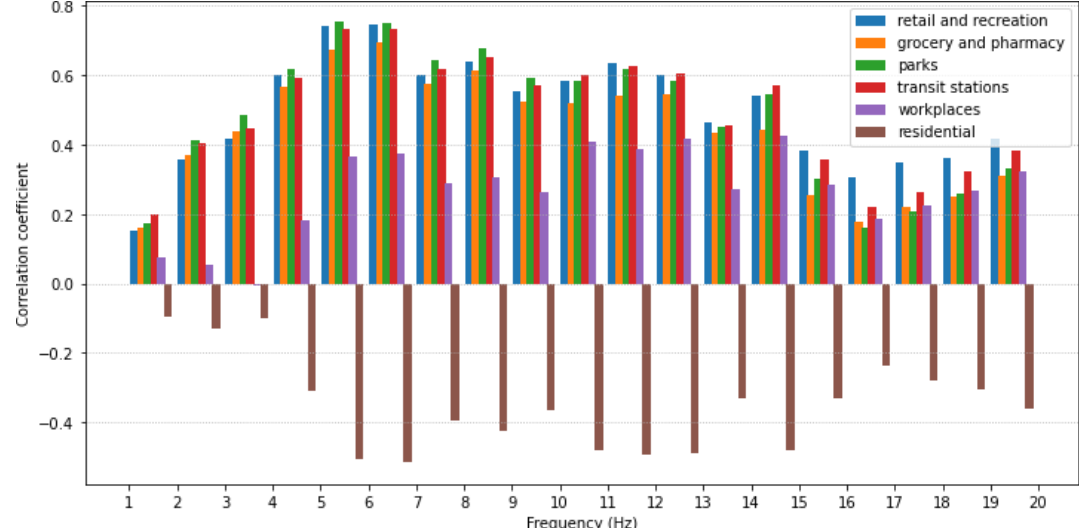
Figure 3. Correlation coefficient between the seismic rms in a narrow 1Hz frequency band from 1 to 20Hz at station R6BB7 and the Google community mobility in the high categories of retail and recreation, groceries and pharmacies, parks, transit stations, workplaces, and residential premises. The period considered extends from 15 February to 1 October 2020, and the highest correlation and anticorrelation are identified between 4 and